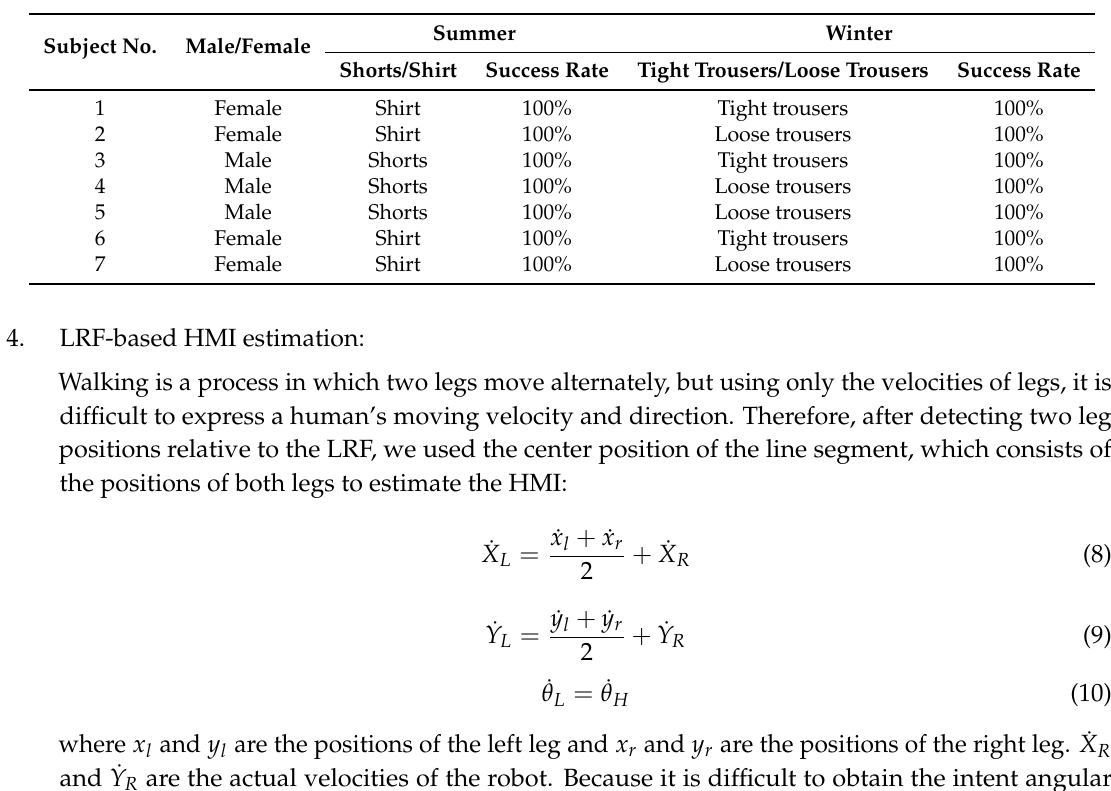
Table 2. The success rate of the leg detection method in different